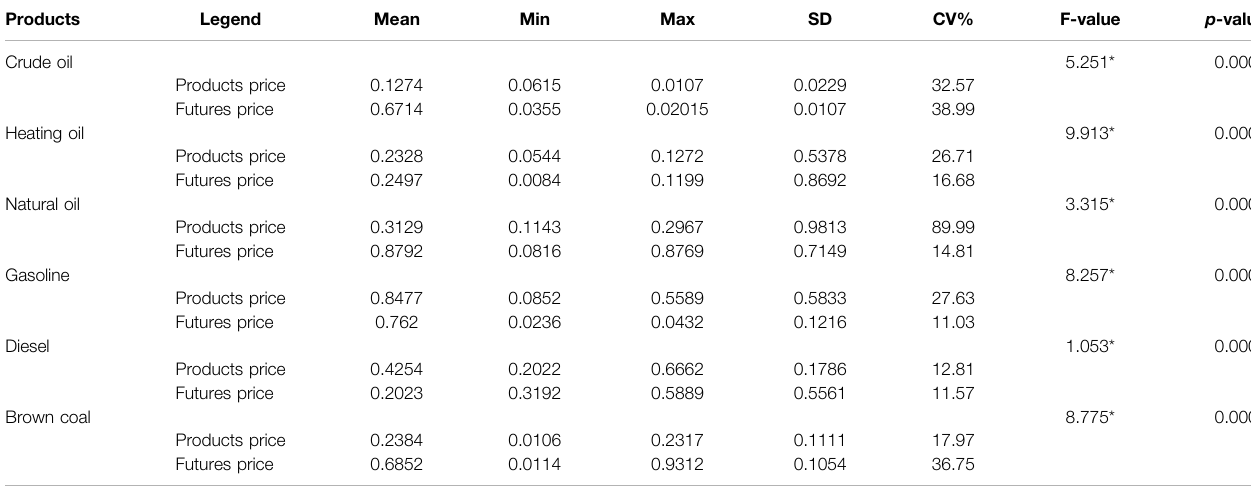
TABLE 1 | Daily energy products spot prices and futures prices. Products